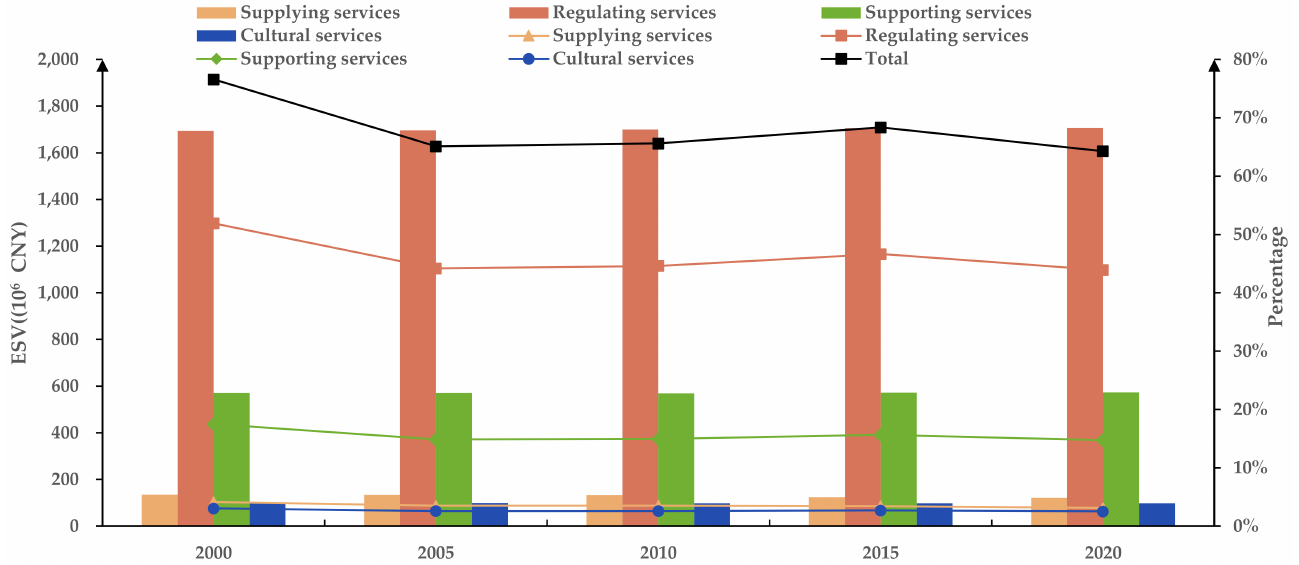
Figure 7. Four categories of ESV and the total ESV of